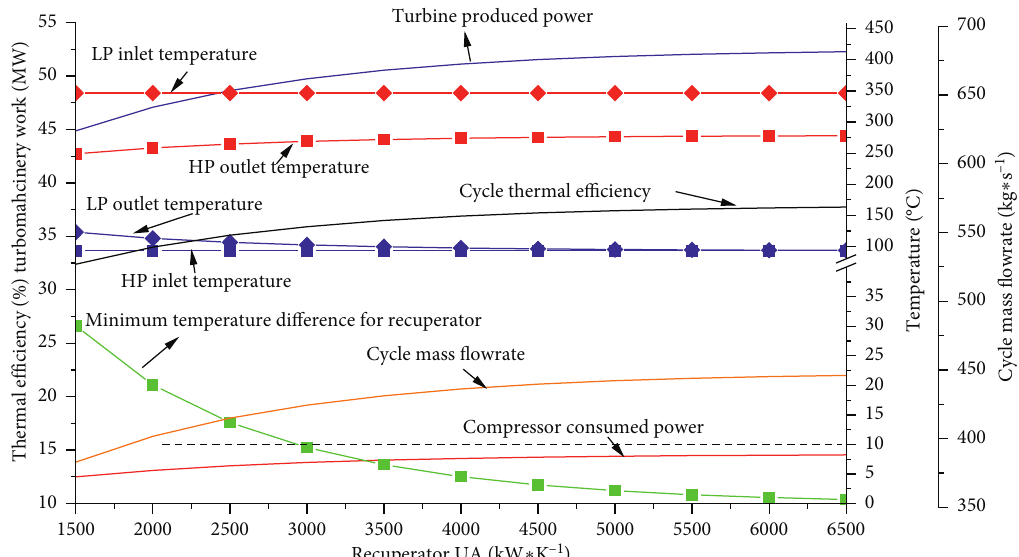
Figure 10: Effects of the heat exchanger UA on the cycle thermal efficiency for water-cooled SBC.